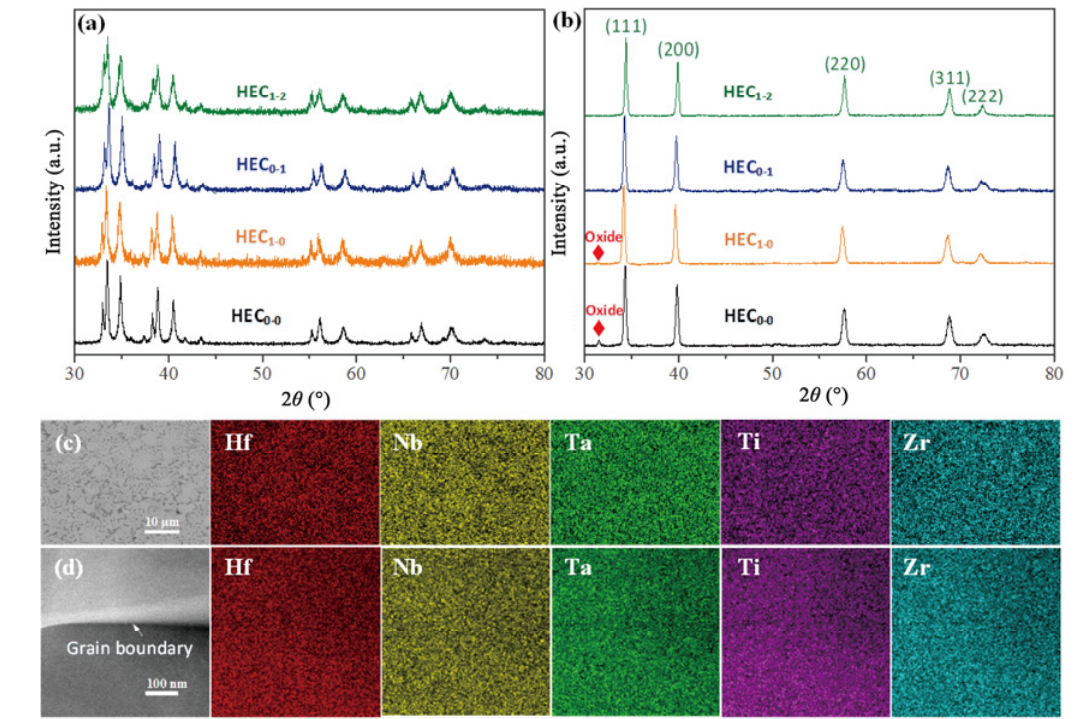
Fig. 1 XRD patterns of (a) powders and (b) sintered compacts of baseline HEC and HEC x ( x = G–CNT) nanocomposite samples, (c) SEM images and corresponding EDS elemental mappings of HEC 1-2 , and (d) TEM images and corresponding EDS elemental mappings of HEC 1-2